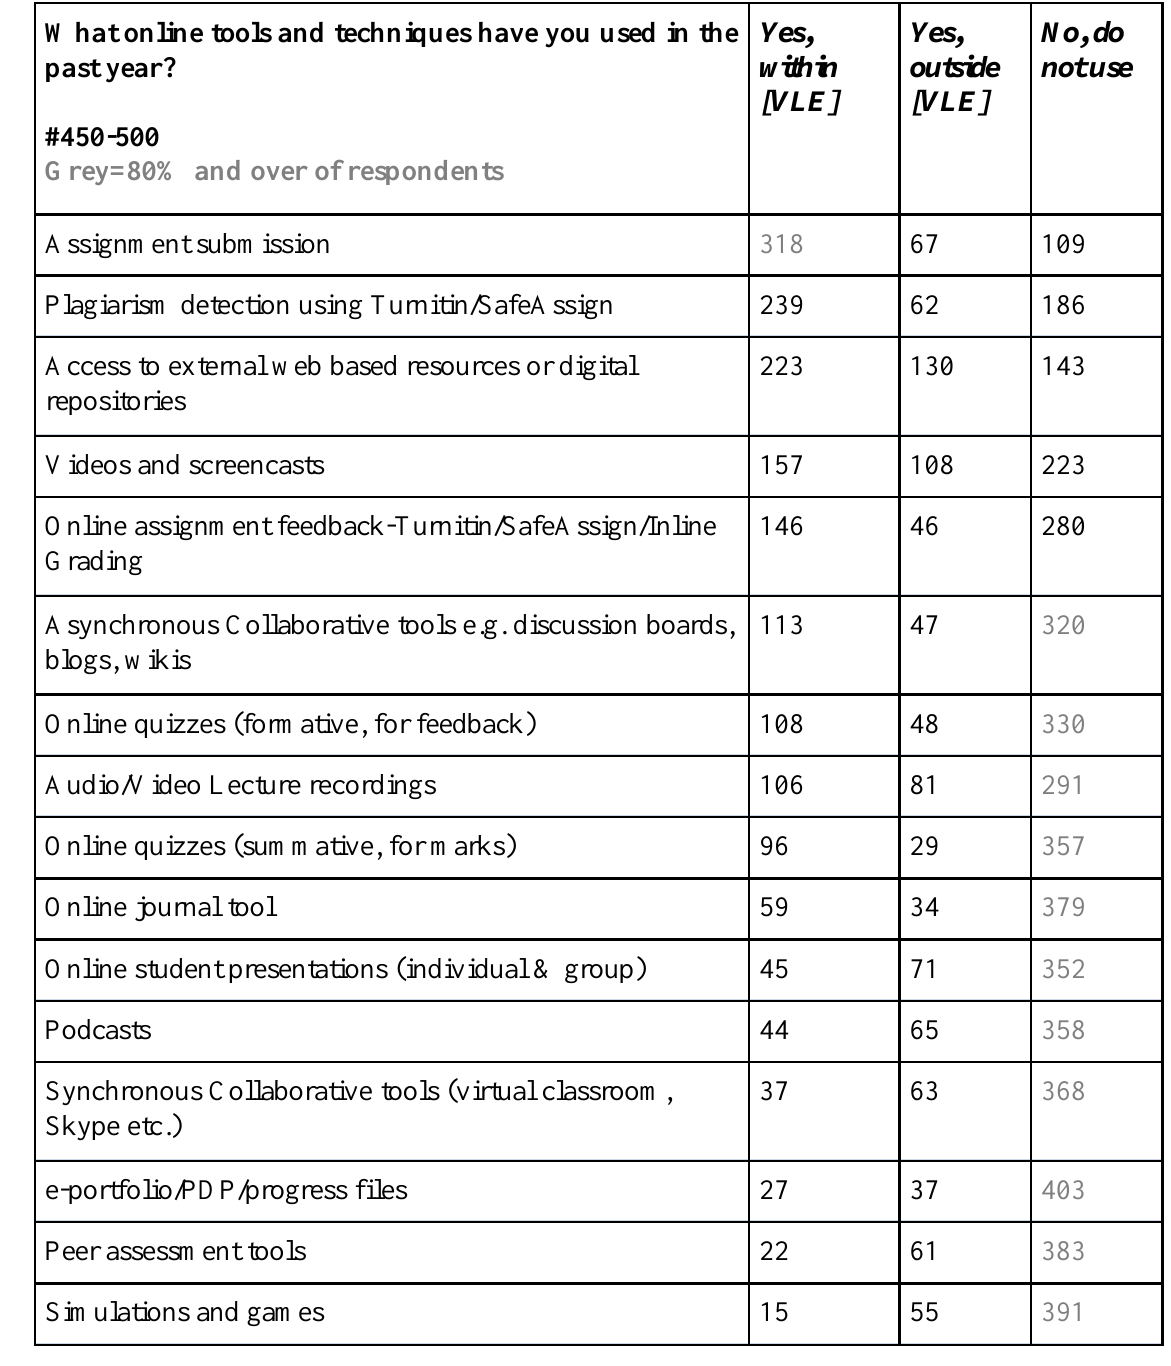
Table 3: Use of online tools inside and outside of